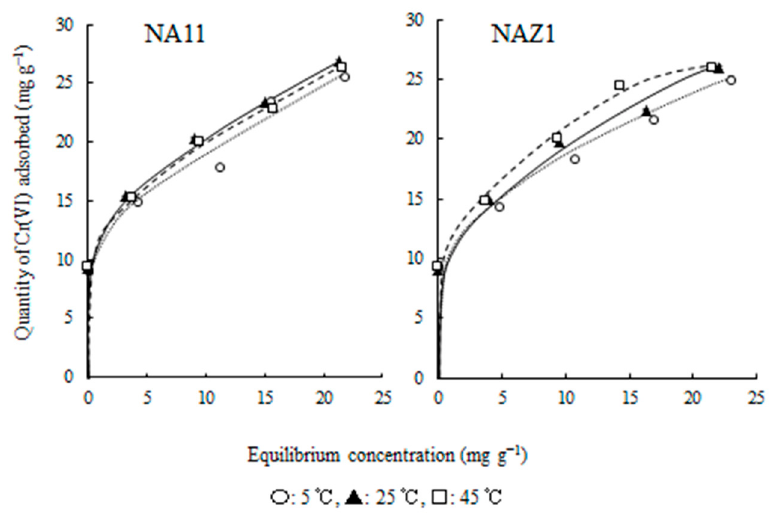
Figure 6. Adsorption isotherms of Cr(VI) using NA11 and NAZ1.